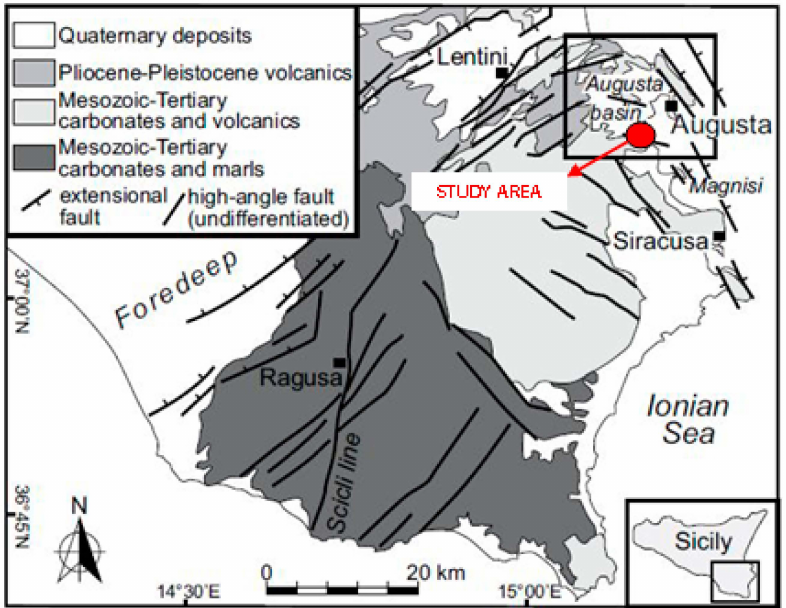
Figure 1. Geological sketch map of the Hyblean Plateau and adjacent fore deep area (After Di Martire et al. [16], modified).